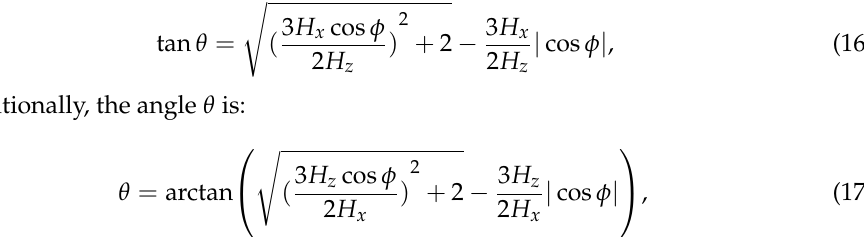
Additionally, the angle θ is: